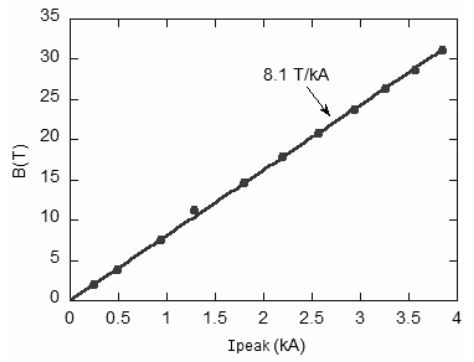
Figure 2. Pulsed current passing through the coil.